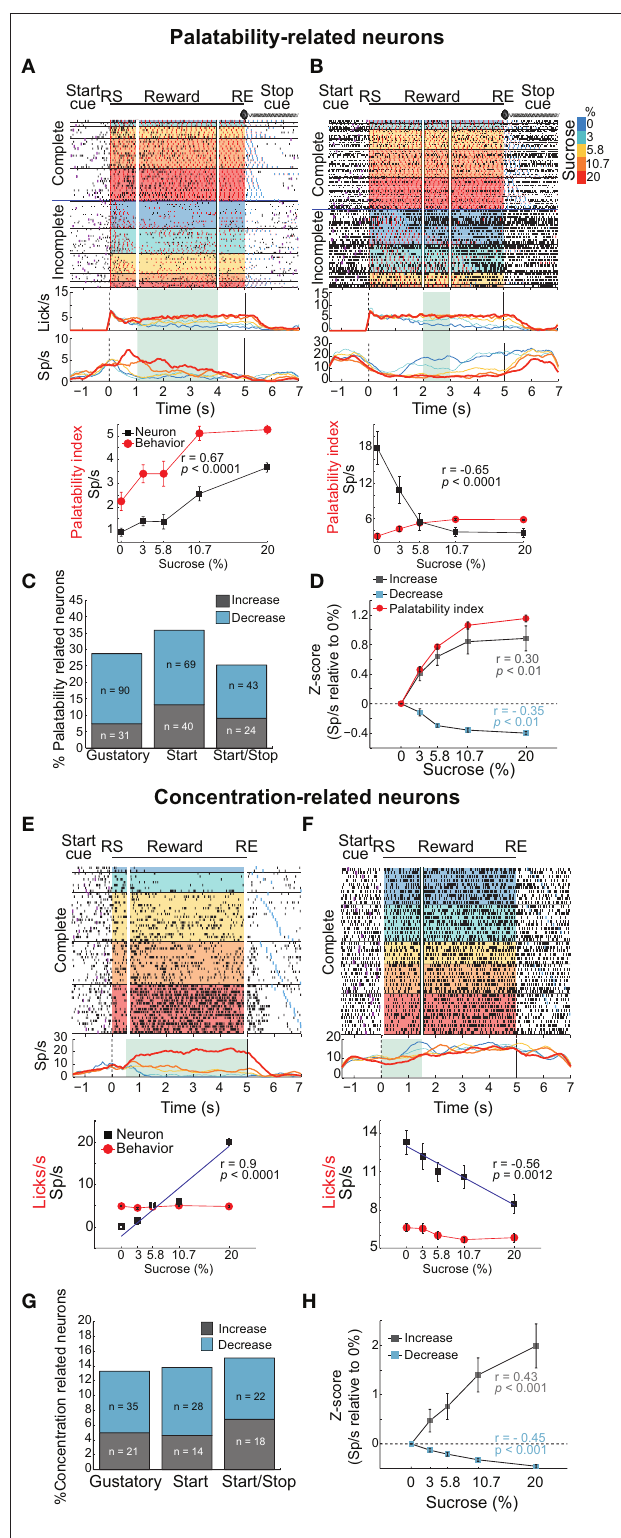
FIGURE 4 | Distinct neuronal populations in the NAcSh track either sucrose evoked palatability oromotor responses or the sucrose